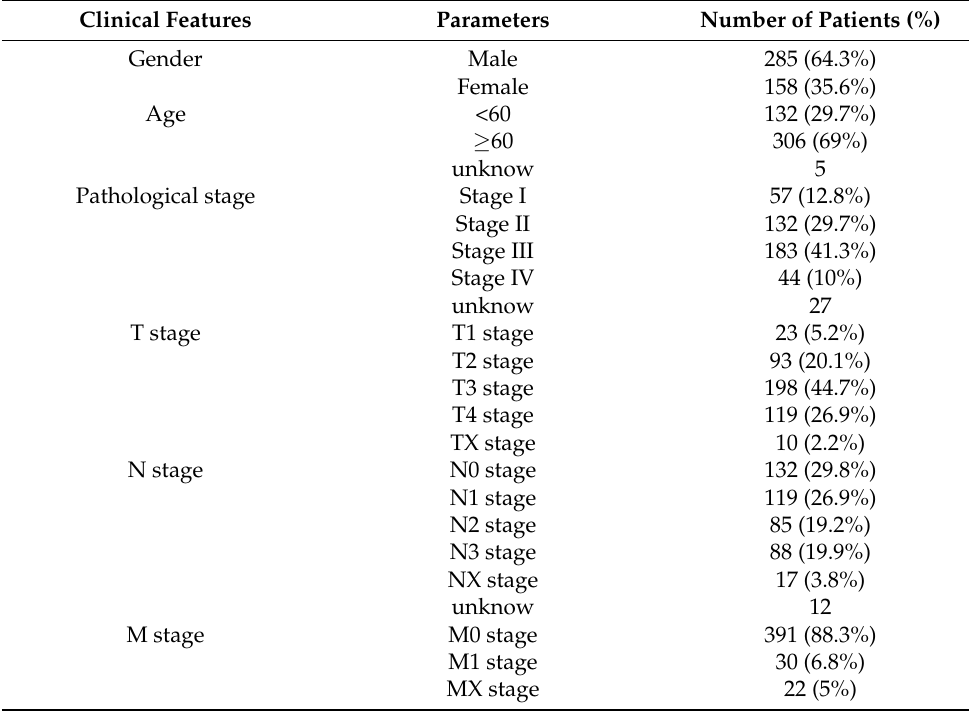
Table 1. Clinical information of 443 STAD